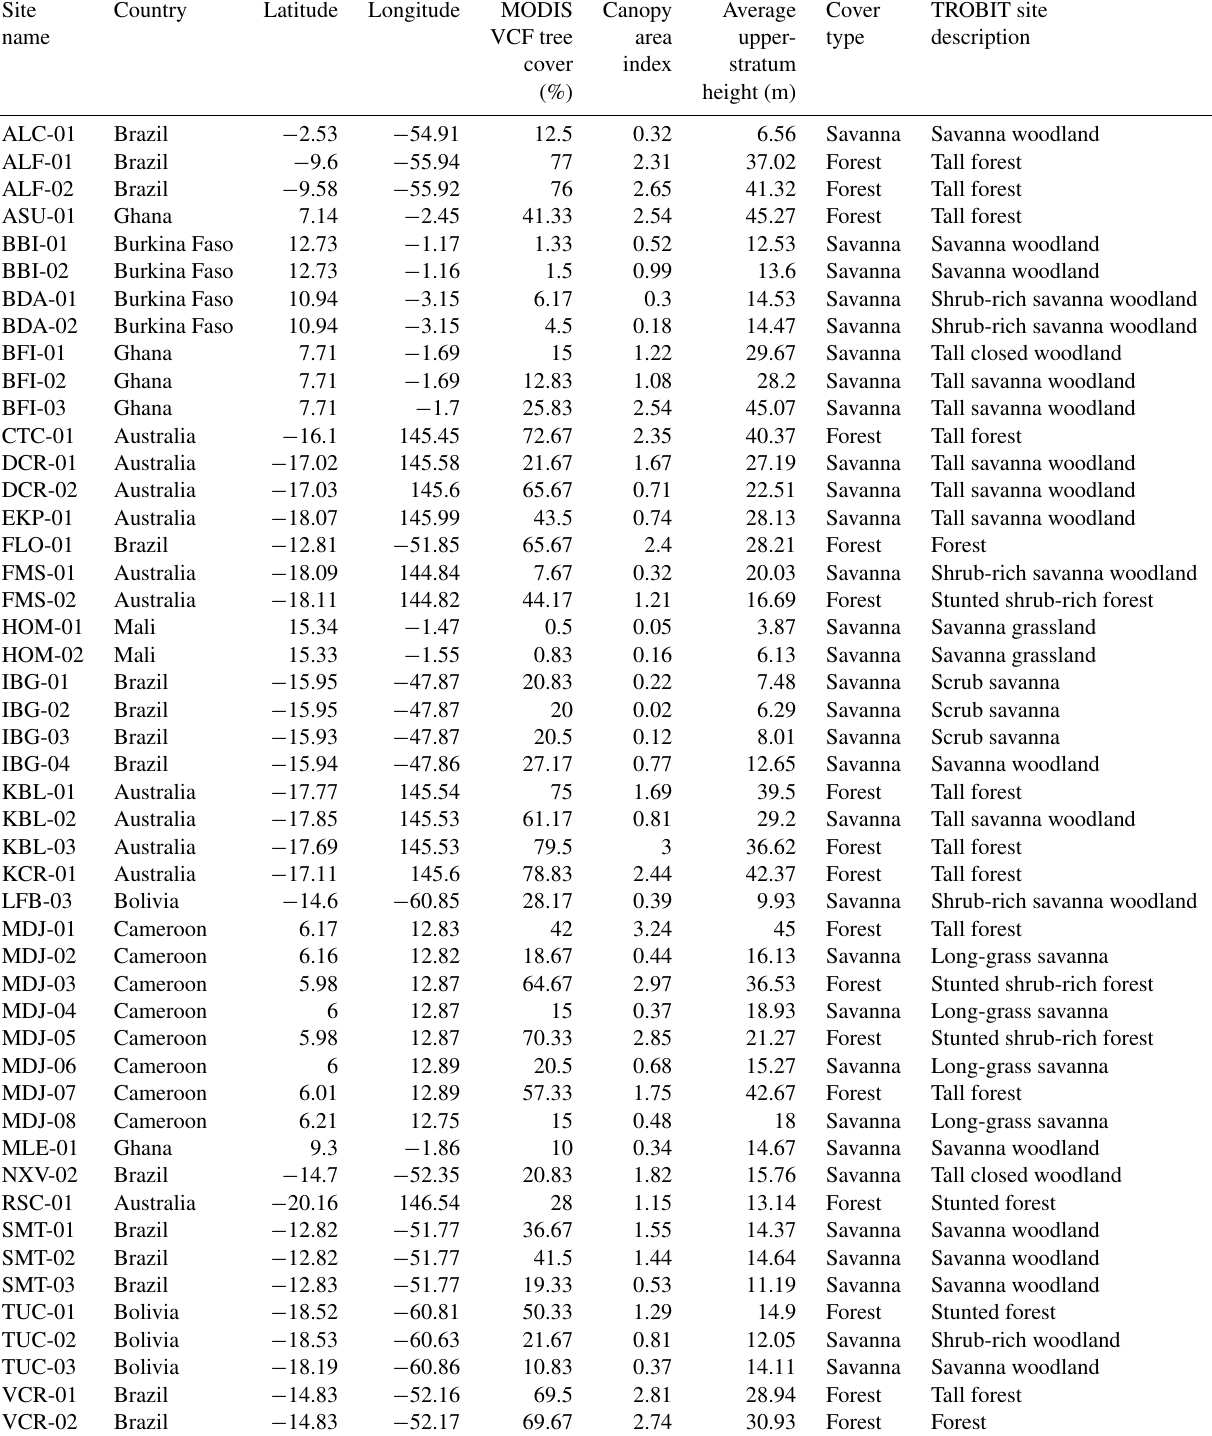
Table A1. Site names, locations, canopy area index values, MODIS VCF percent tree cover values, cover type, and TROBIT site